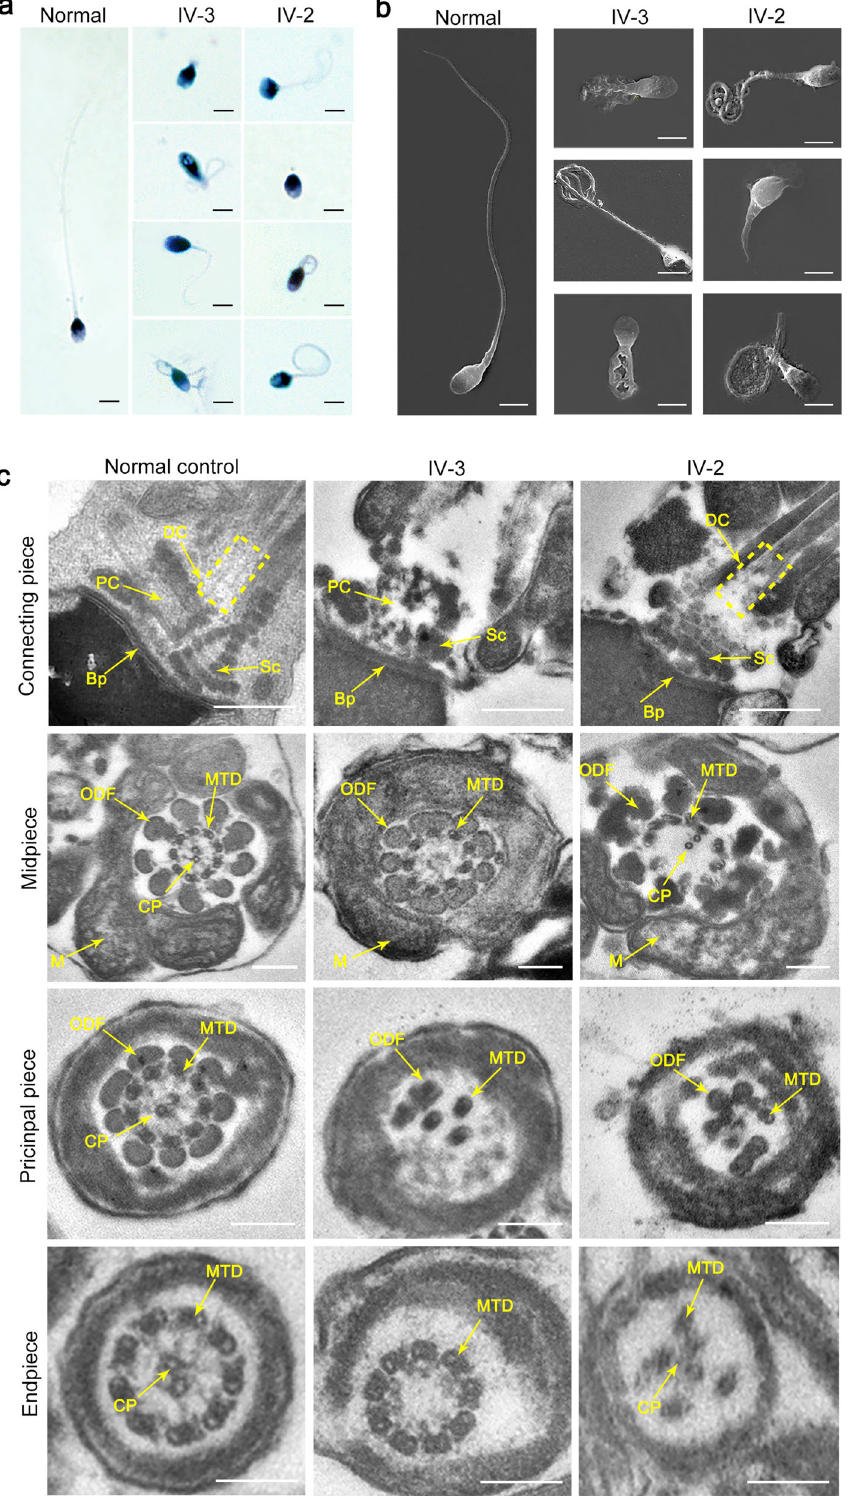
Fig. 1 Morphological and ultrastructural defects in spermatozoa from two infertile siblings. Abnormalities in sperm morphology observed in the two siblings by light microscopy ( a ) and scanning electron microscopy (SEM) ( b ) (scale bars, 5 µ m). c The aberrations in sperm ultrastructure detected in the two affected individuals. The missing or incomplete PC, DC and Sc were found in the connecting piece, and the disorganized arrangements or absence of CPs, MTDs, and ODFs were observed in the patients ’ sperm fl agella. Dotted box denotes DC. PC proximal centriole, DC distal centriole, Sc segmented column, Bp basal plate, CP central-pair microtubules, ODF outer dense fi bers, MTD peripheral microtubule doublets, M mitochondria, IV-3 the proband, IV- 2 the affected sibling (scale bars, 100